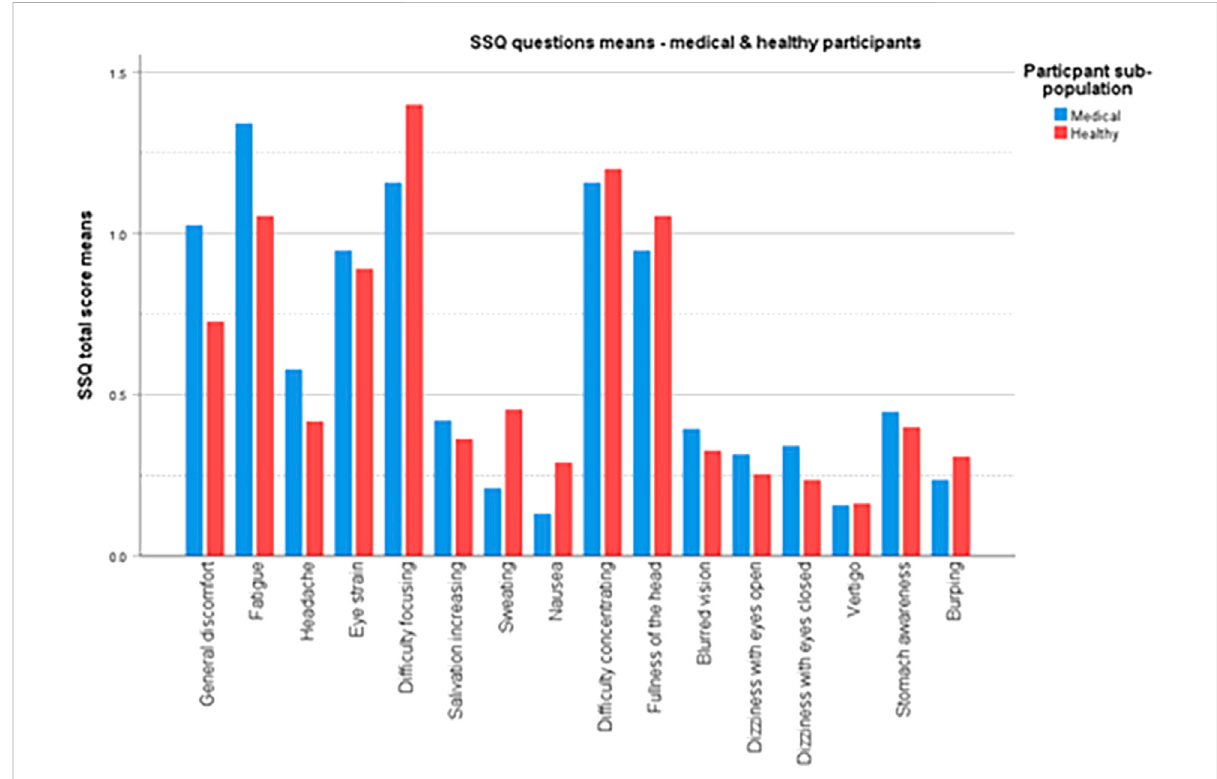
FIGURE 3 Individual questions SSQ mean